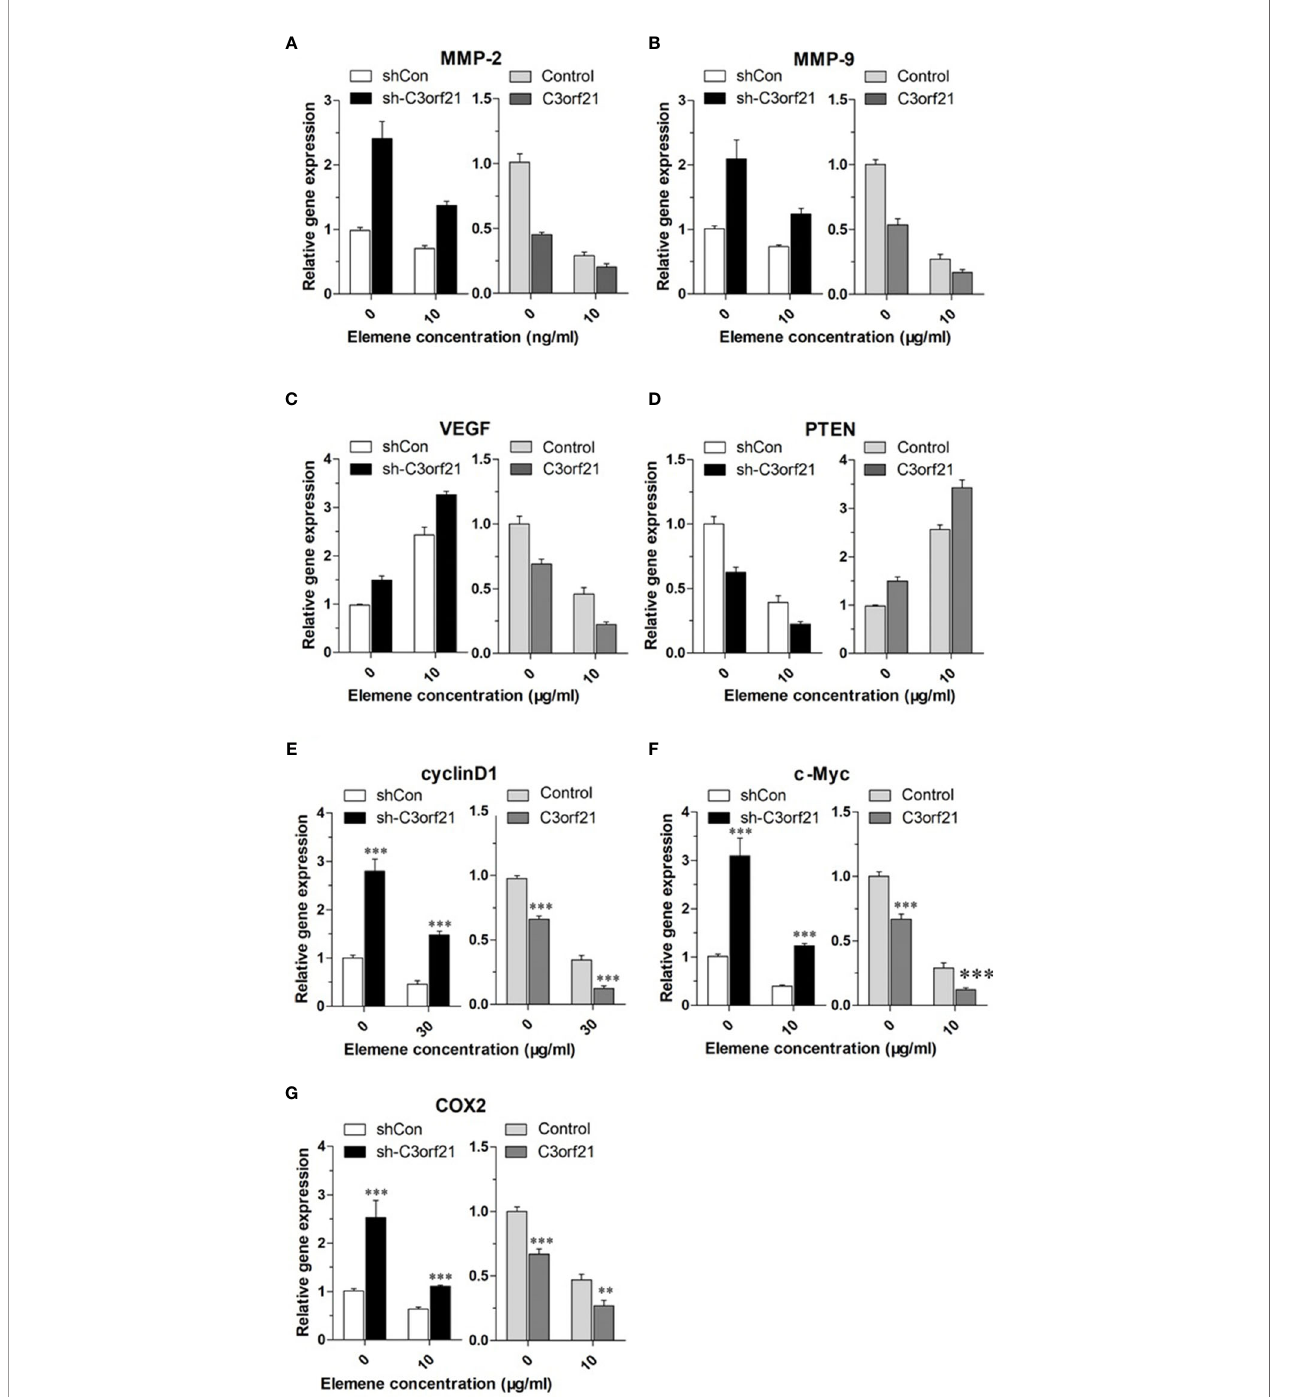
FIGURE 7 | Beta-elemene modulates the expression of several regulators and signal events in NSCLC cells, dependent on C3orf21 expression. The indicated NSCLC cells were treated with, or without, beta-elemene for 24 h and the relative levels of MMP-2 (A) , MMP-9 (B) , VEGF (C) , PTEN (D) Cyclin (E) , C-Myc (F) , and COX2 (G) in the indicated NSCLC cells were quanti fi ed by RT-PCR. Data are present as mean ± SD of each group from at least three biological experiments. **P < 0.01 and ***P < 0.001 vs. the